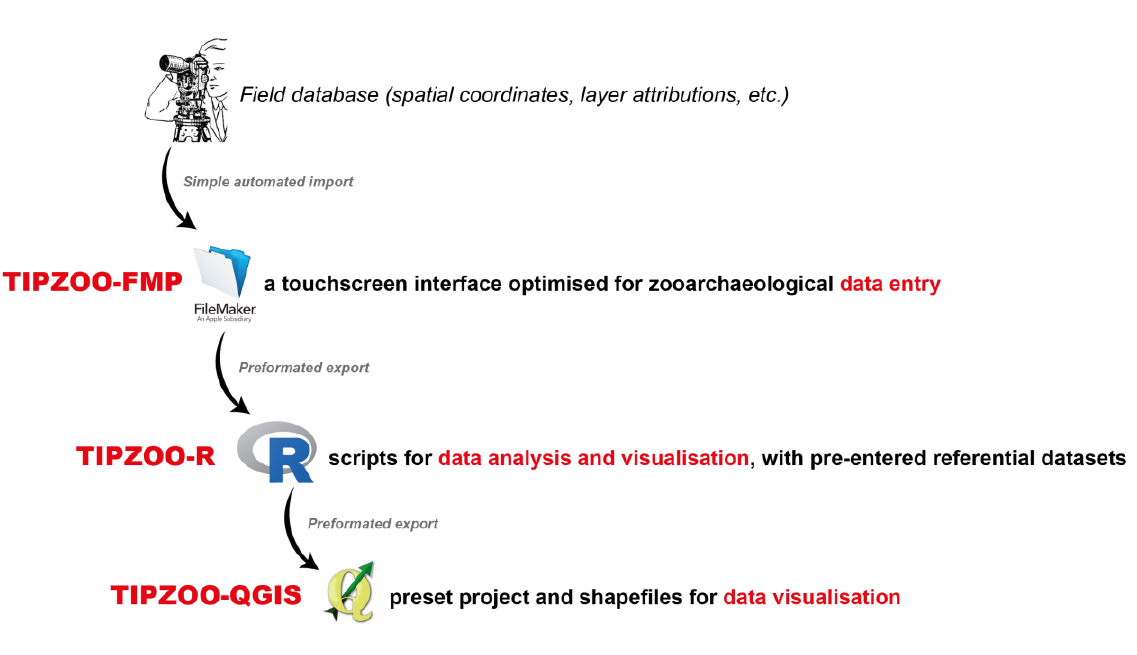
Figure 1 . General workflow organization of the three components (in red) of